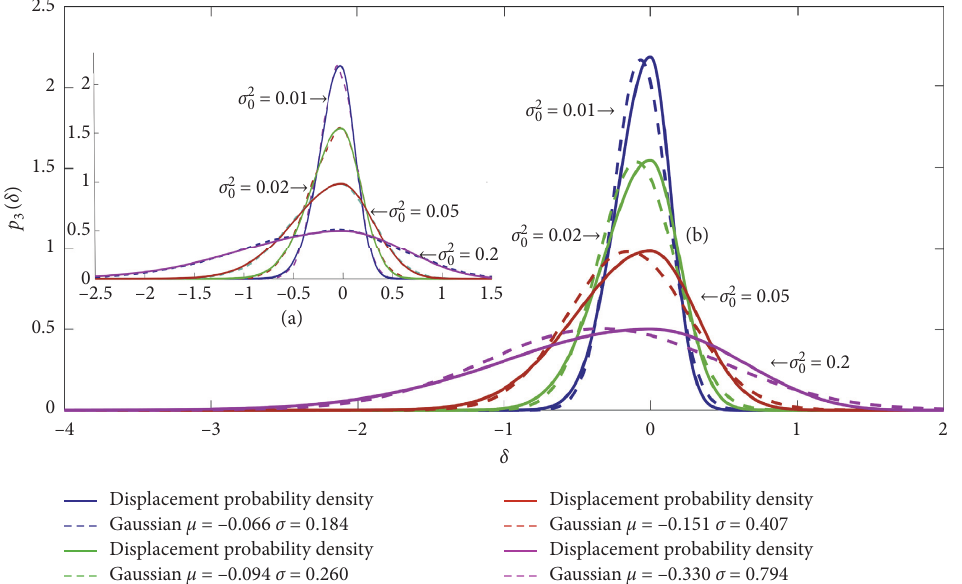
. (a) Comparison of the numerical and theoretical solution. (b) The result 0